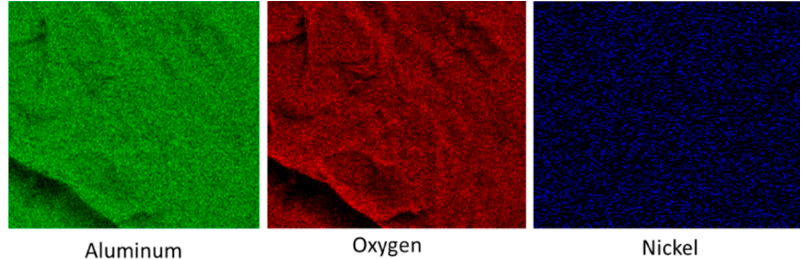
Figure 1. SEM-EDX mapping of catalyst.